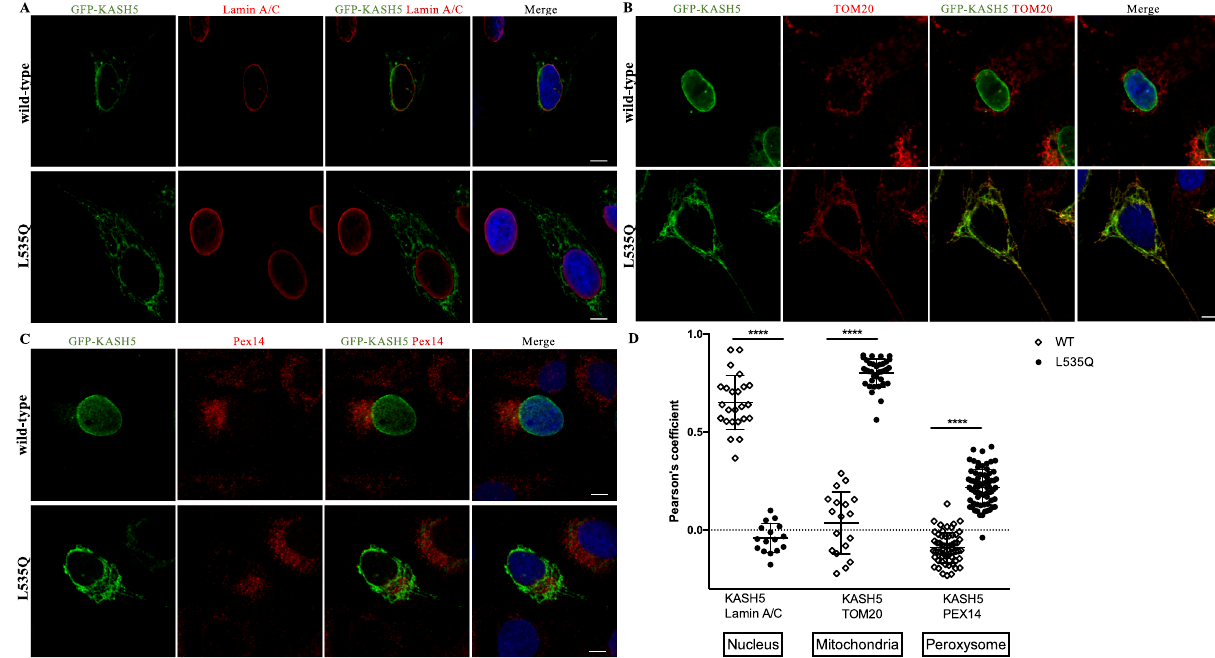
Figure 2. The L535Q KASH5 localizes to the mitochondria. U2OS cells grown on coverslips were transfected with an N-terminal GFP-tagged version of wild-type or L535Q KASH5. The subcellular localization was determined by immunostaining with organelle-specific protein markers. ( A ) Nuclear localization was assessed using an anti-lamin A/C antibody (red). ( B ) Mitochondria localization was assessed with an anti-TOM20 antibody (red). ( C ) Peroxisome localization was assessed with an anti-PEX14 antibody (red). ( D ) Pearson’s correlation coefficient between GFP-KASH5 and organelle markers. KASH5 vs Lamin A/C: N = 24, KASH5 vs TOM20: N = 35 and KASH5 vs Pex14: N = 72. The values indicate − 1: opposing, 0: no and 1 complete colocalization. Scale bar 10 μm. ****P < 0.0001; ***P < 0.0002. The experiment was repeated seven